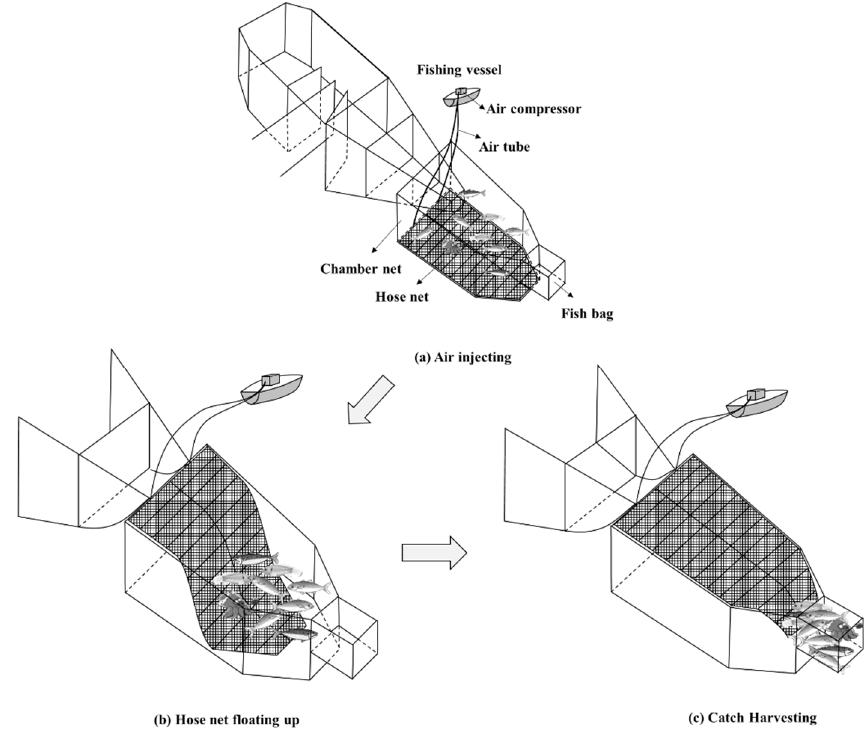
Figure 2. Catch-hauling process of the novel automated hose net system.